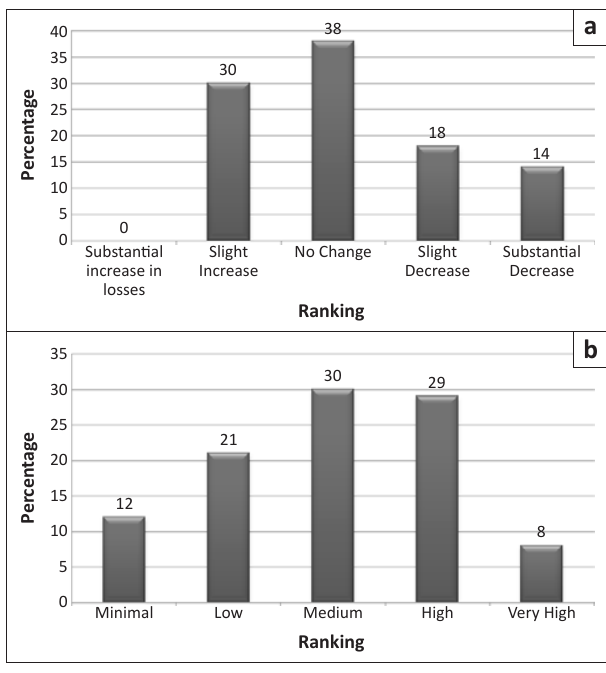
FIGURE 6: (a) Percentage of respondents’ views on changes in disaster losses since 2005. (b) Perception of respondents on disasters and hazards within their